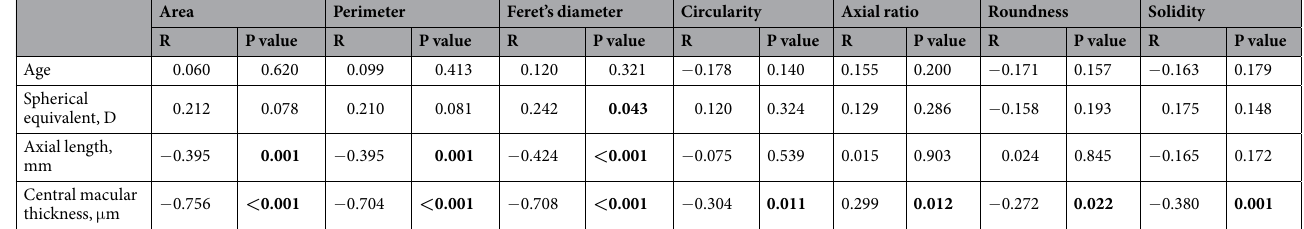
Table 4. Correlation of clinical findings and each parameter.